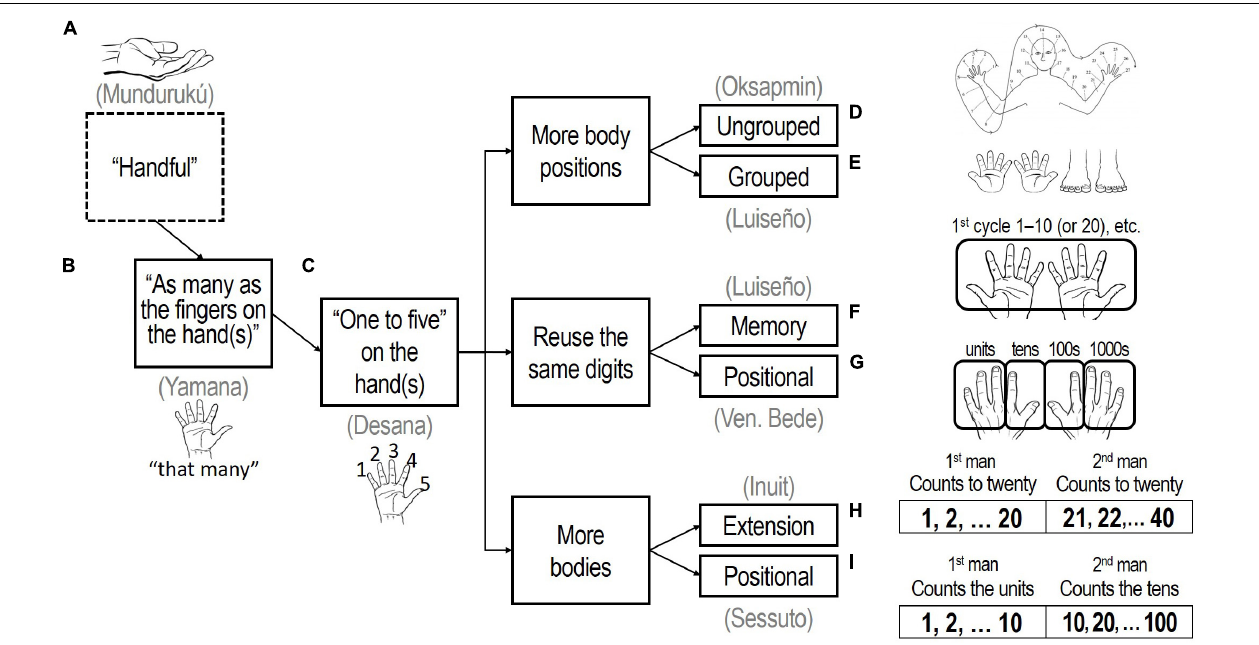
FIGURE 1 | How the hand is used in counting affects numerical structure and organization. Key: (A) a handful; (B) without counting the fingers; (C) with the fingers counted; (D) adding other body parts; (E) adding the feet; (F) remembering additional cycles; (G) using the fingers to track cycles; (H) sequential collaboration; and (I) exponential collaboration. Oksapmin body-counting panel (D) is adapted from Saxe (2012), Figure 12, p. 46; images of hands and feet are from the public domain.